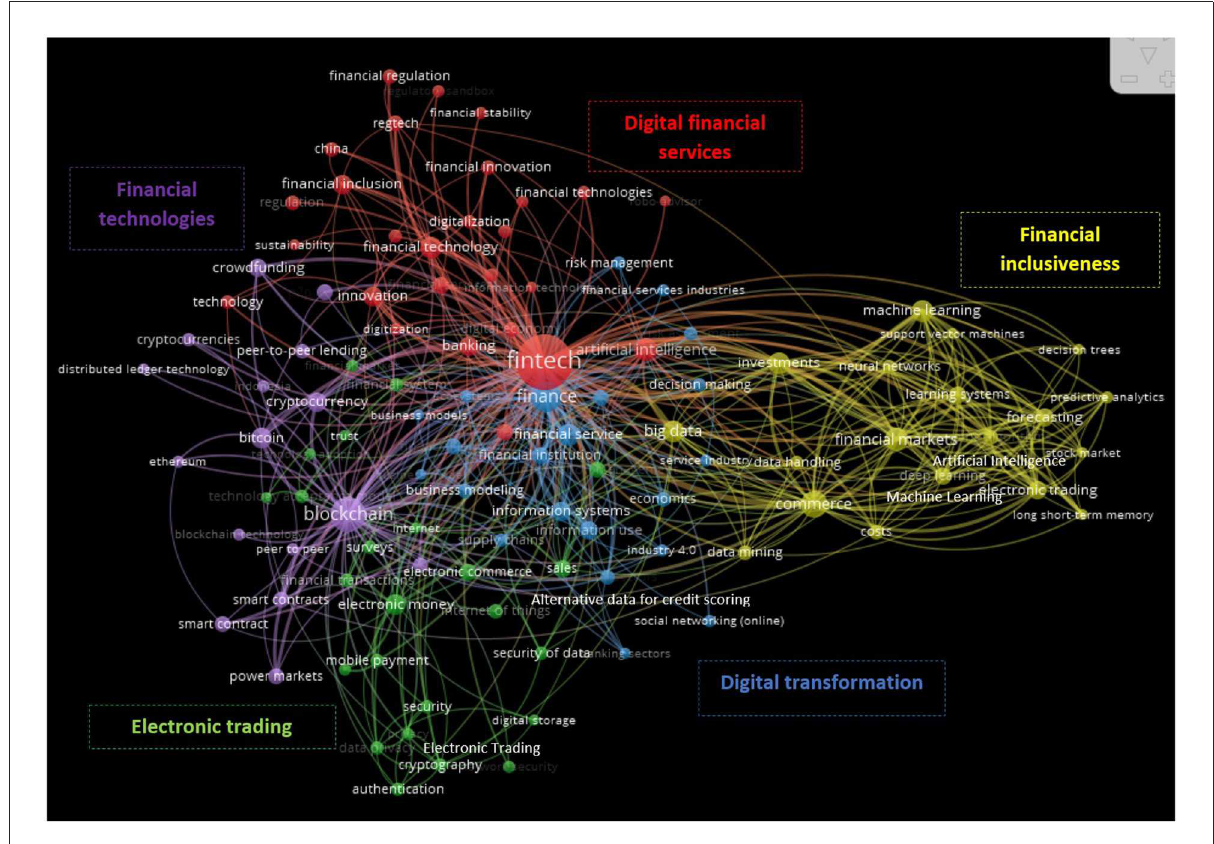
FIGURE5 A bibliometric map on MSMEs digital financing under the COVID-19 pandemic. Source: The authors, based on the VOSviewer